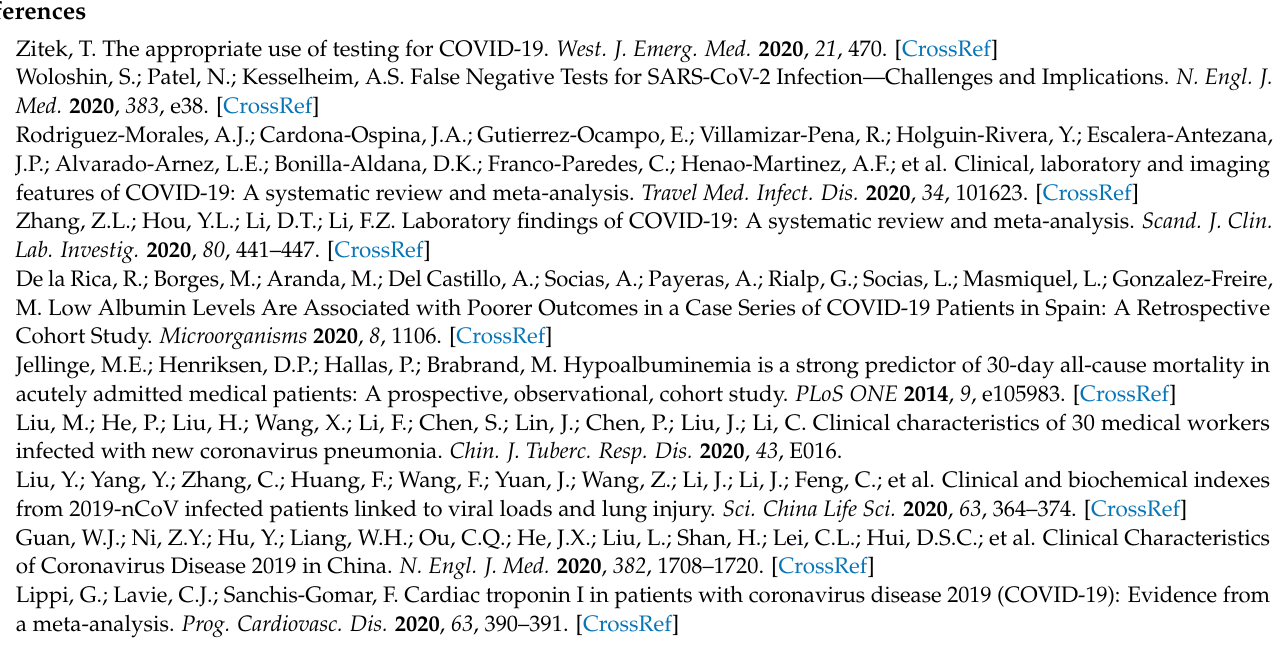
parametric bivariate correlation, Figure S1: Patients’ flowchart, Figure S2: ROC curves for eosinophil percentage and absolute count, NLR, DELR, and WLR, Figure S3: ROC curve for Cumulative score in case-control